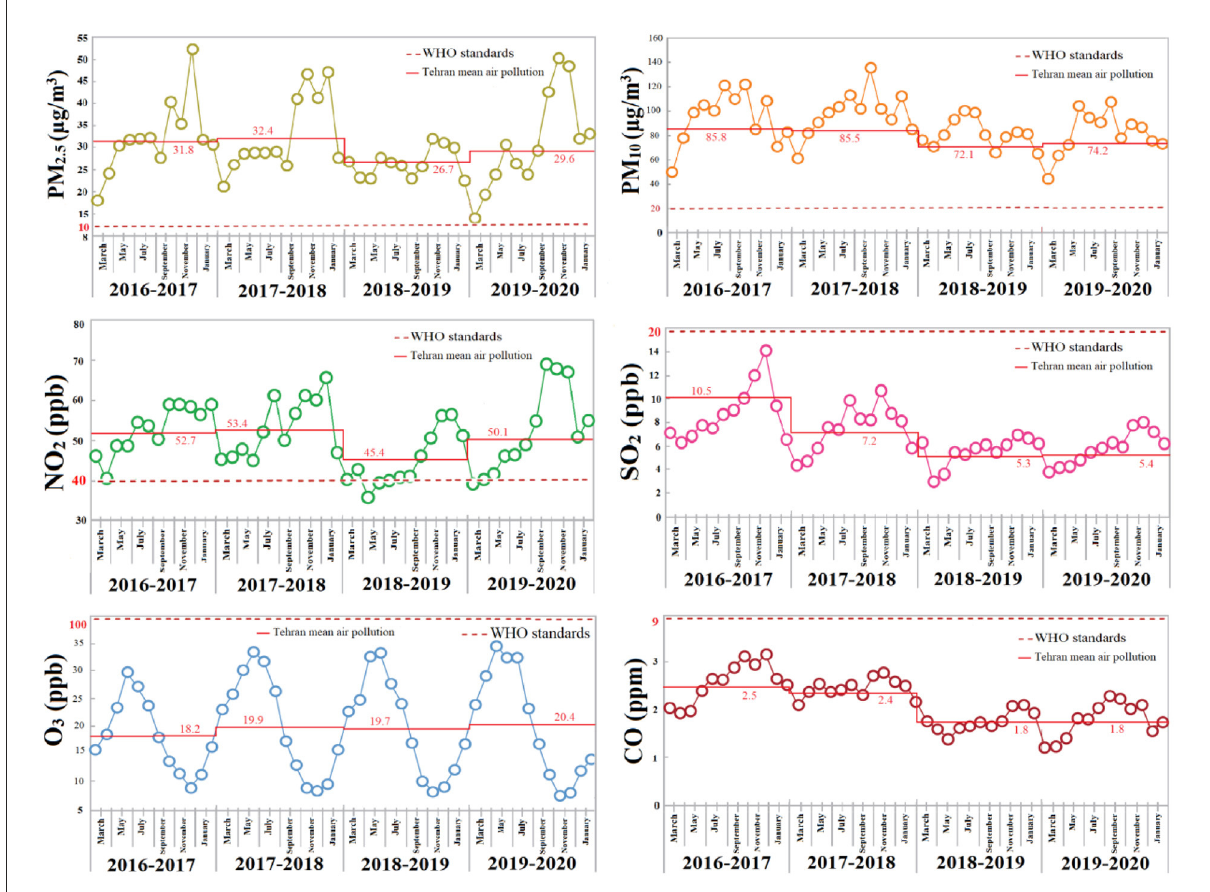
FIGURE2 The monthly trend of PM 10 , PM 2.5 , O 3 , NO 2 , CO, and SO 2 of Tehran for